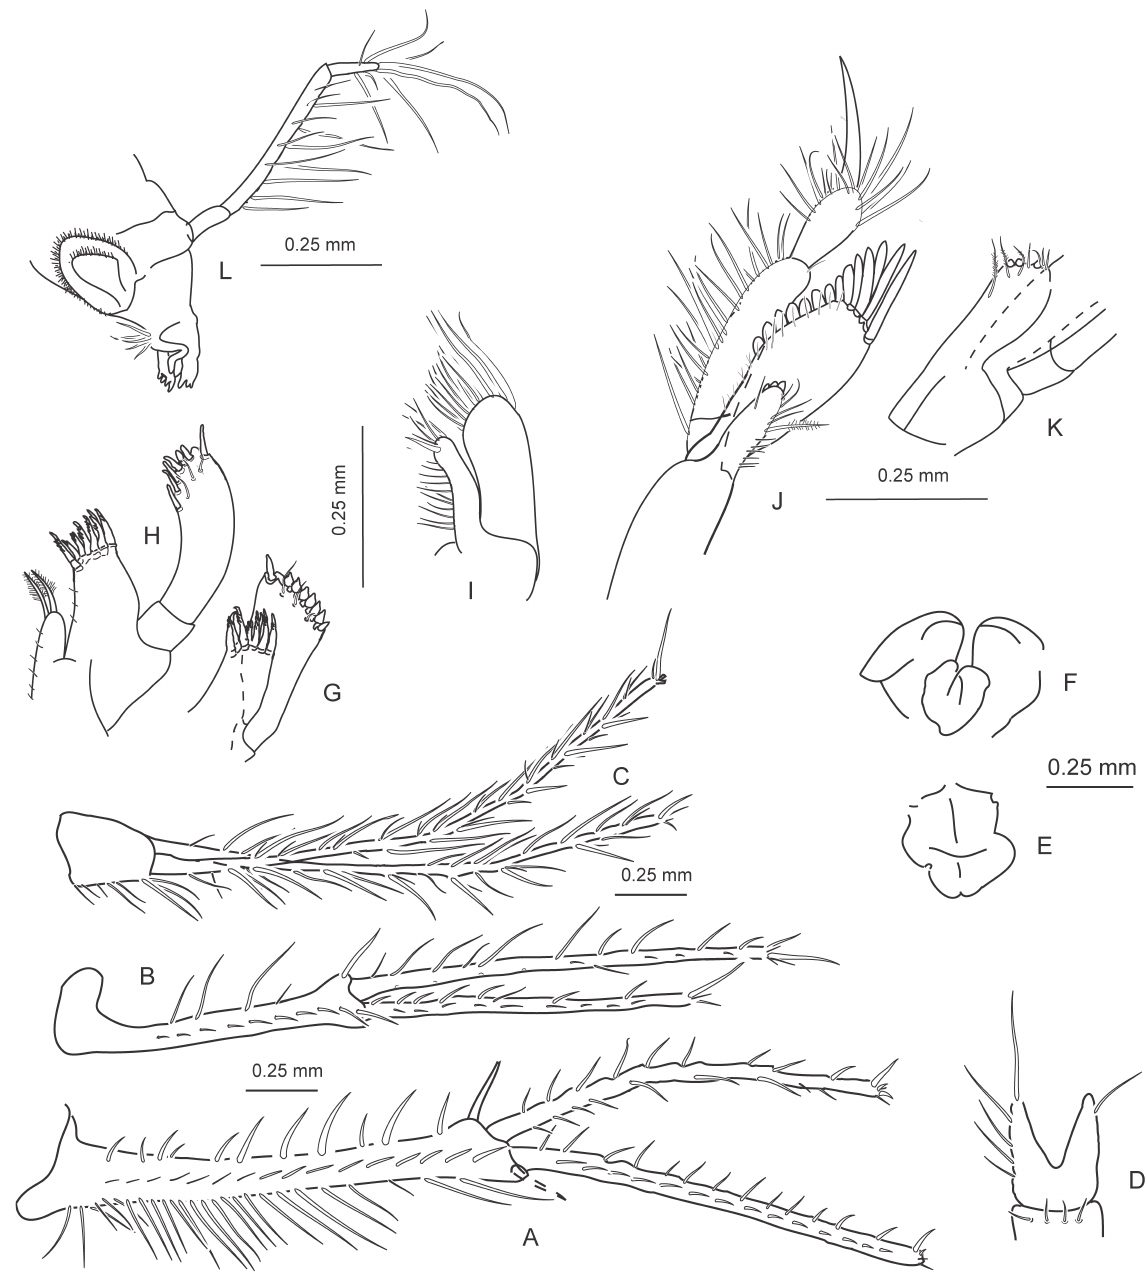
Fig. 8. Lepechinella norvegica sp. nov., holotype, ♂. A . Left U1. B . Left U2. C . U3. D . Telson. E . Upper lip. F . Lower lip. G–H . Left and right Mx1. I . Right Mx2. J–K . Left and right Mxp. L . Left